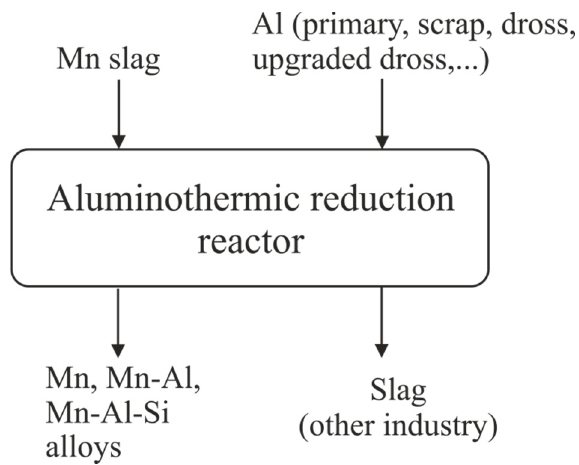
Figure 9. A simplified flowsheet of the process showing its flexibility.